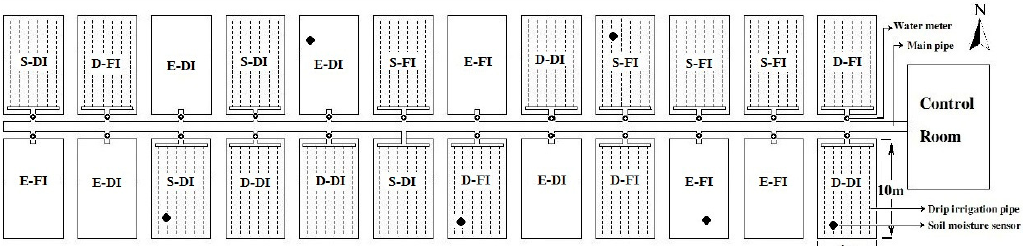
Figure 9. Layout of the experimental plots. D-FI and D-DI, the DSSIS system using RZWQM2 model simulated water stress under full irrigation and deficit irrigation; S-FI and S-DI, sensor–based full irrigation and deficit irrigation; E-FI and E-DI, experience–based full irrigation and deficit irrigation.